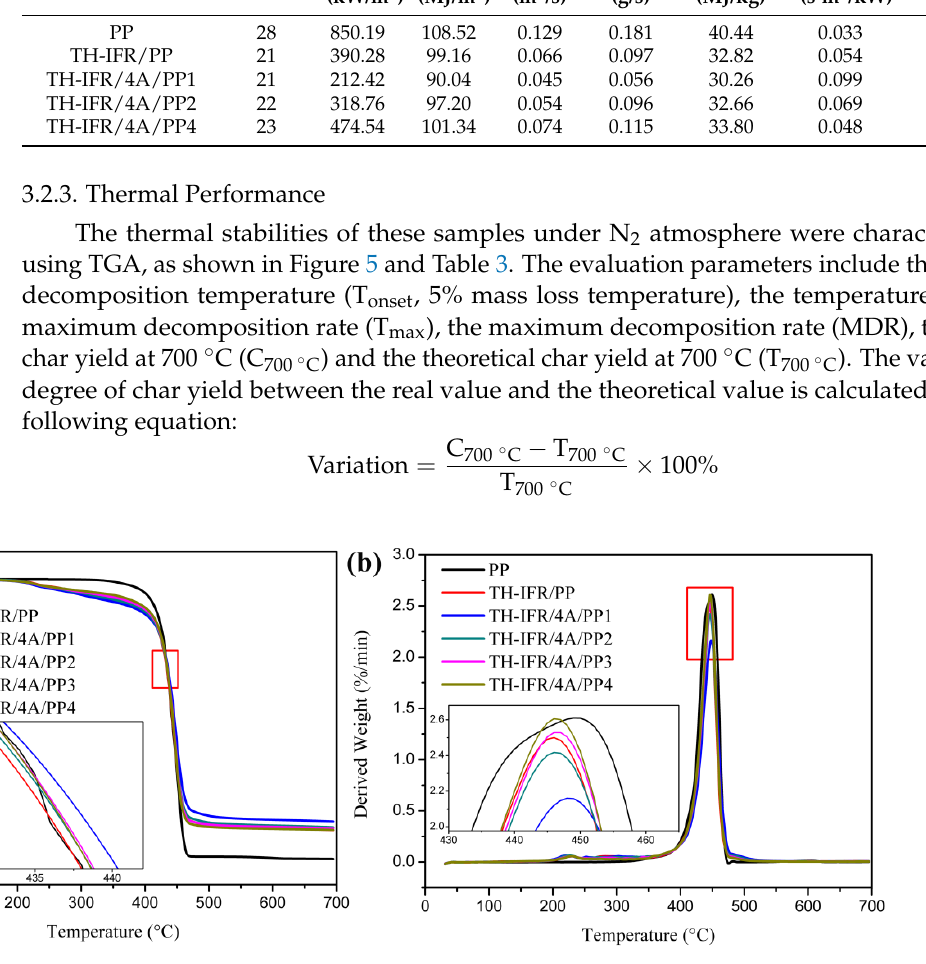
Figure 5. The TG ( a ) and DTG ( b ) curves of pure PP and FR PP composites. Table 3. The TGA parameters of pure PP and FR PP composites.